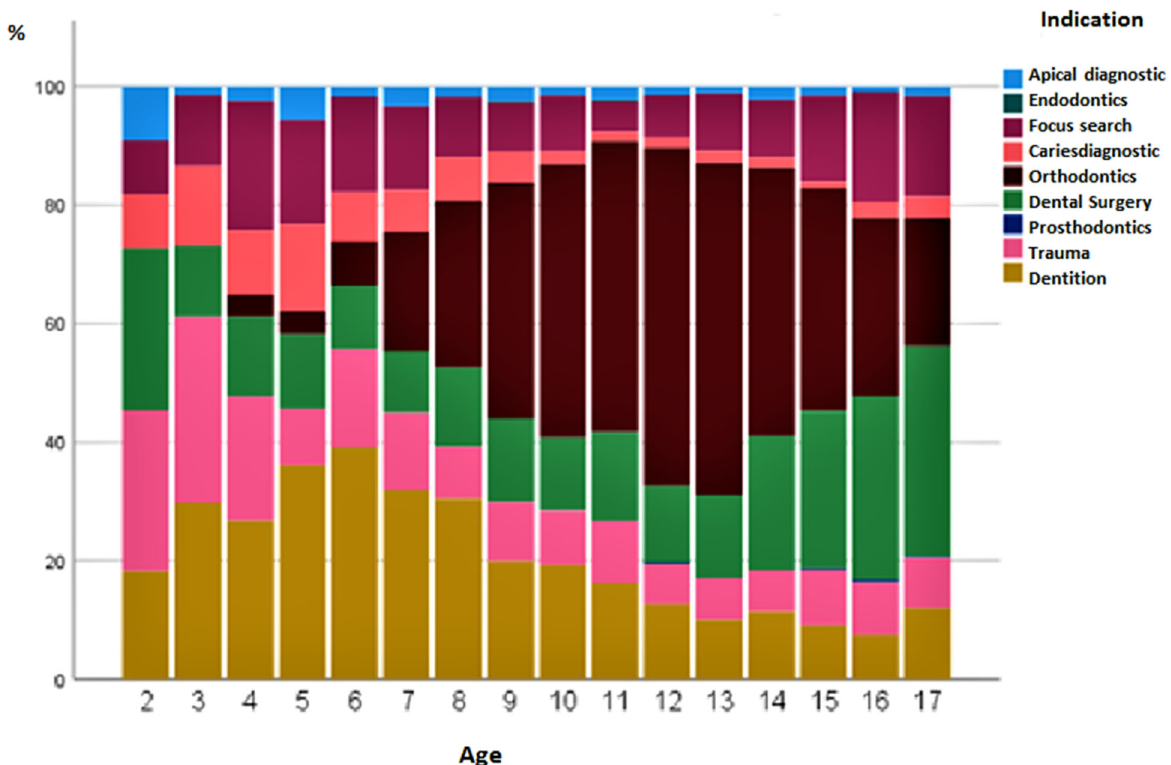
Figure 3. Distribution of dental indications for radiography from 1 to 18 years of age.